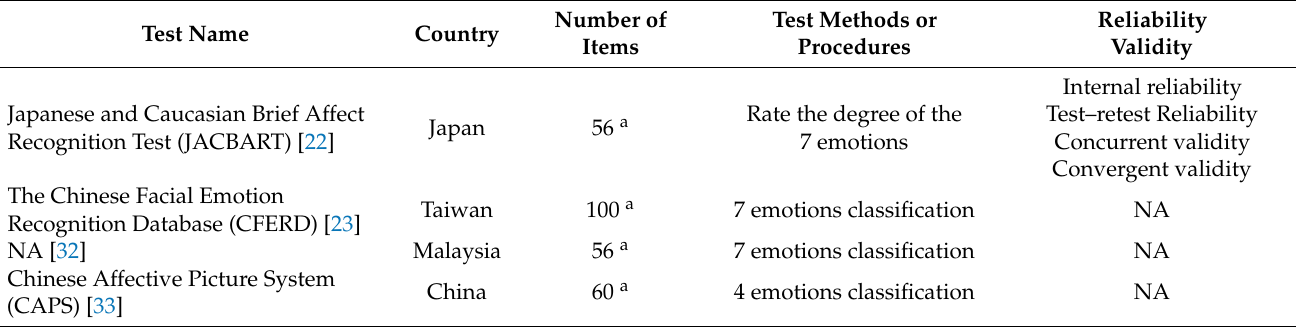
Table 1. Single-modality emotion recognition tests with eastern facial stimulus.